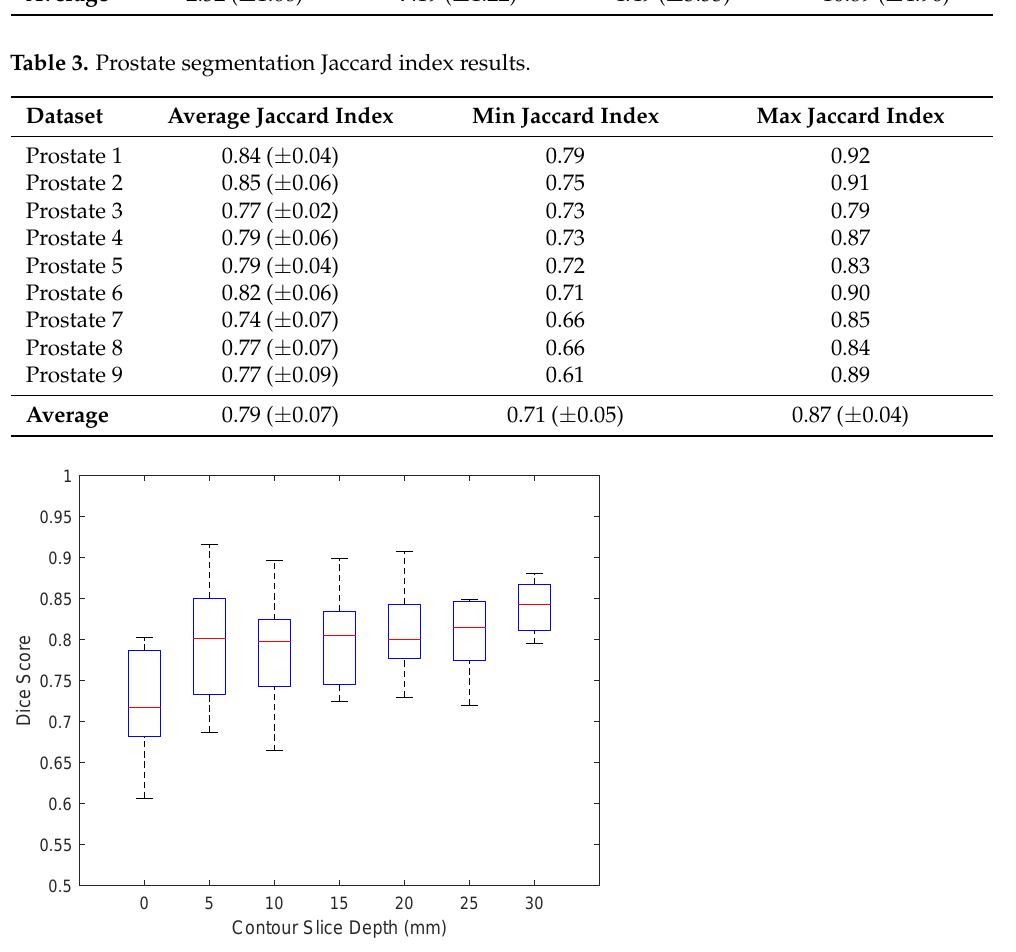
Figure 15. Jaccard index score of prostate contouring algorithm with respect to contour depth in the z